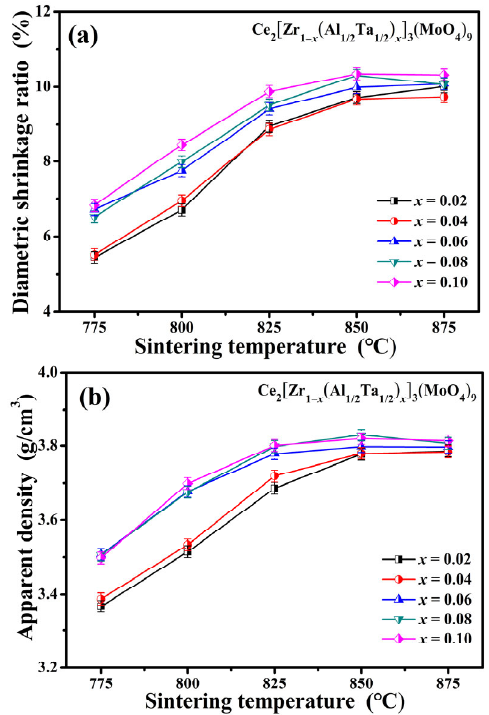
Fig. 6 (a) Diametric shrinkage ratio of CZMAT ceramics as a function of sintering temperature; (b) apparent density of CZMAT ceramics as a function of sintering temperature.